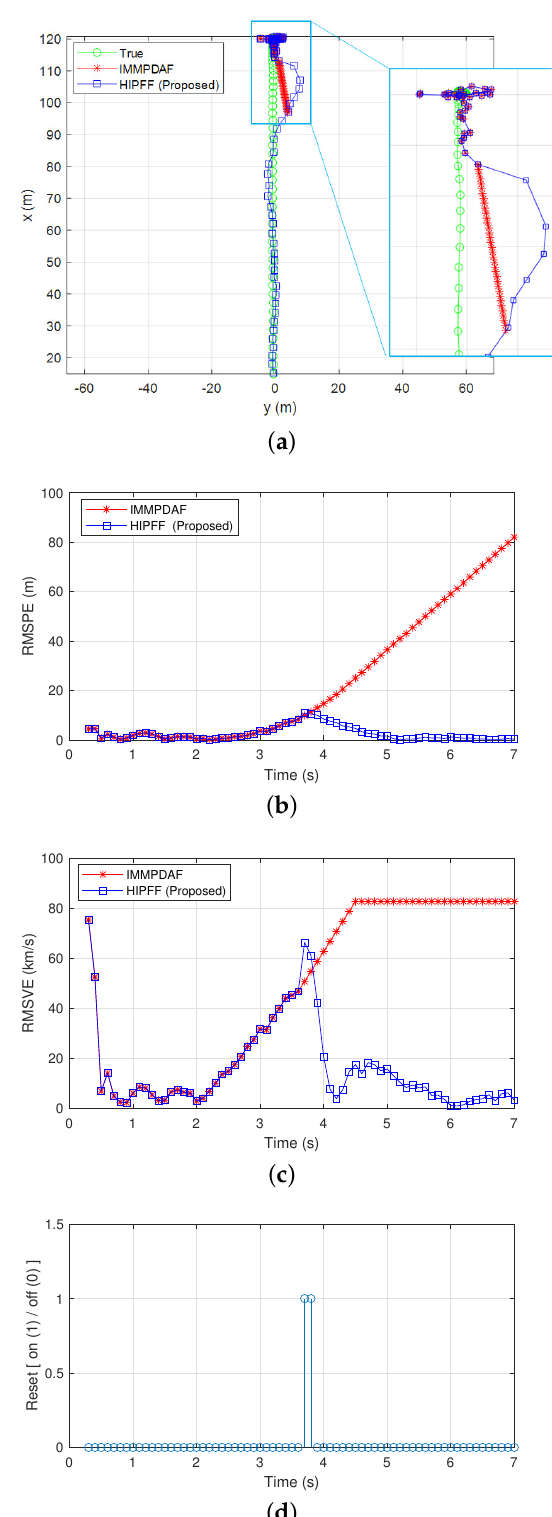
Figure 4. Simulation results in case of divergent interacting multiple model probabilistic data associa- tion filter (IMMPDAF): ( a ) true and estimated positions; ( b ) RMSPE; ( c ) RMSVE; and ( d ) reset